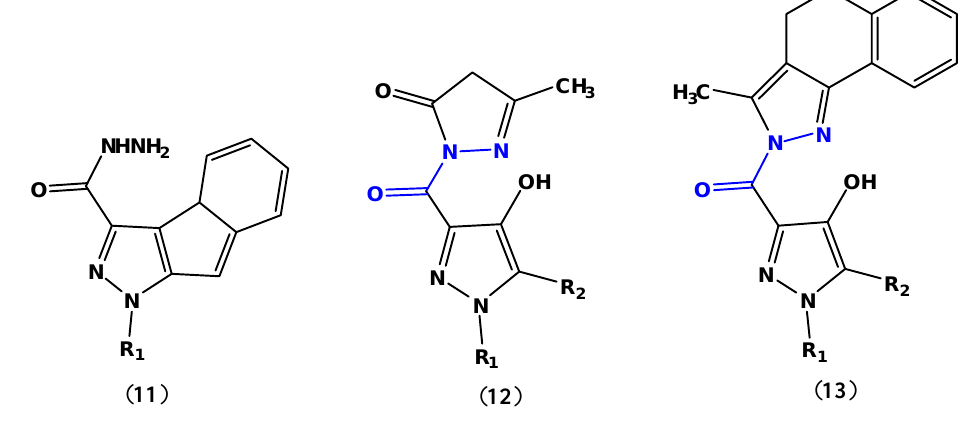
Figure 3. Derivatives that exhibit antitumor activity: 1- H -pyrazole-3-carbohydrazide = phenyl), 4-hydroxypyrazole derivatives ( 12 and 13 , R derivatives ( 11 , R 1 R = H), 1- H -pyrazole-5-carbohydrazide derivatives ( 15 , R 2 -C(O)CH -O-phenyl, R = 4- substituted -benzyl or 4- substituted -phenyl) and ( 16 , R 2 2 = benzyl or 4- substituted -benzyl). The compounds 12 and 13 have the carbohydrazide R 2 function ( A ) internalized into a heterocyclic